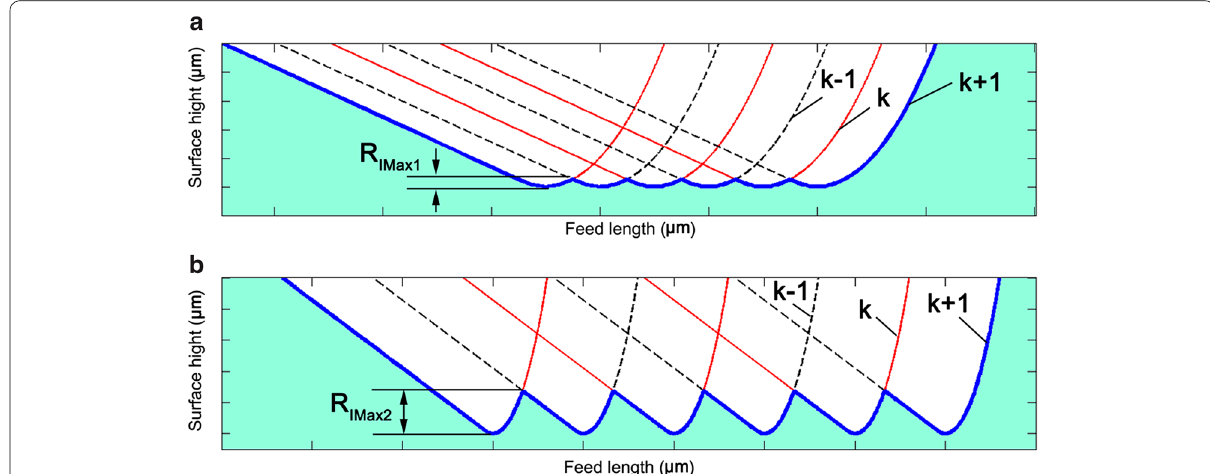
Figure 3 Ideal machined surface in micro milling: a 1st case of the ideal machined surface, b 2nd case of the ideal machined surface